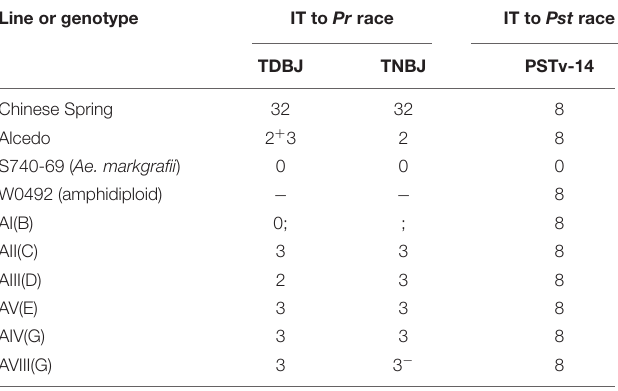
Line or genotype IT to Pr